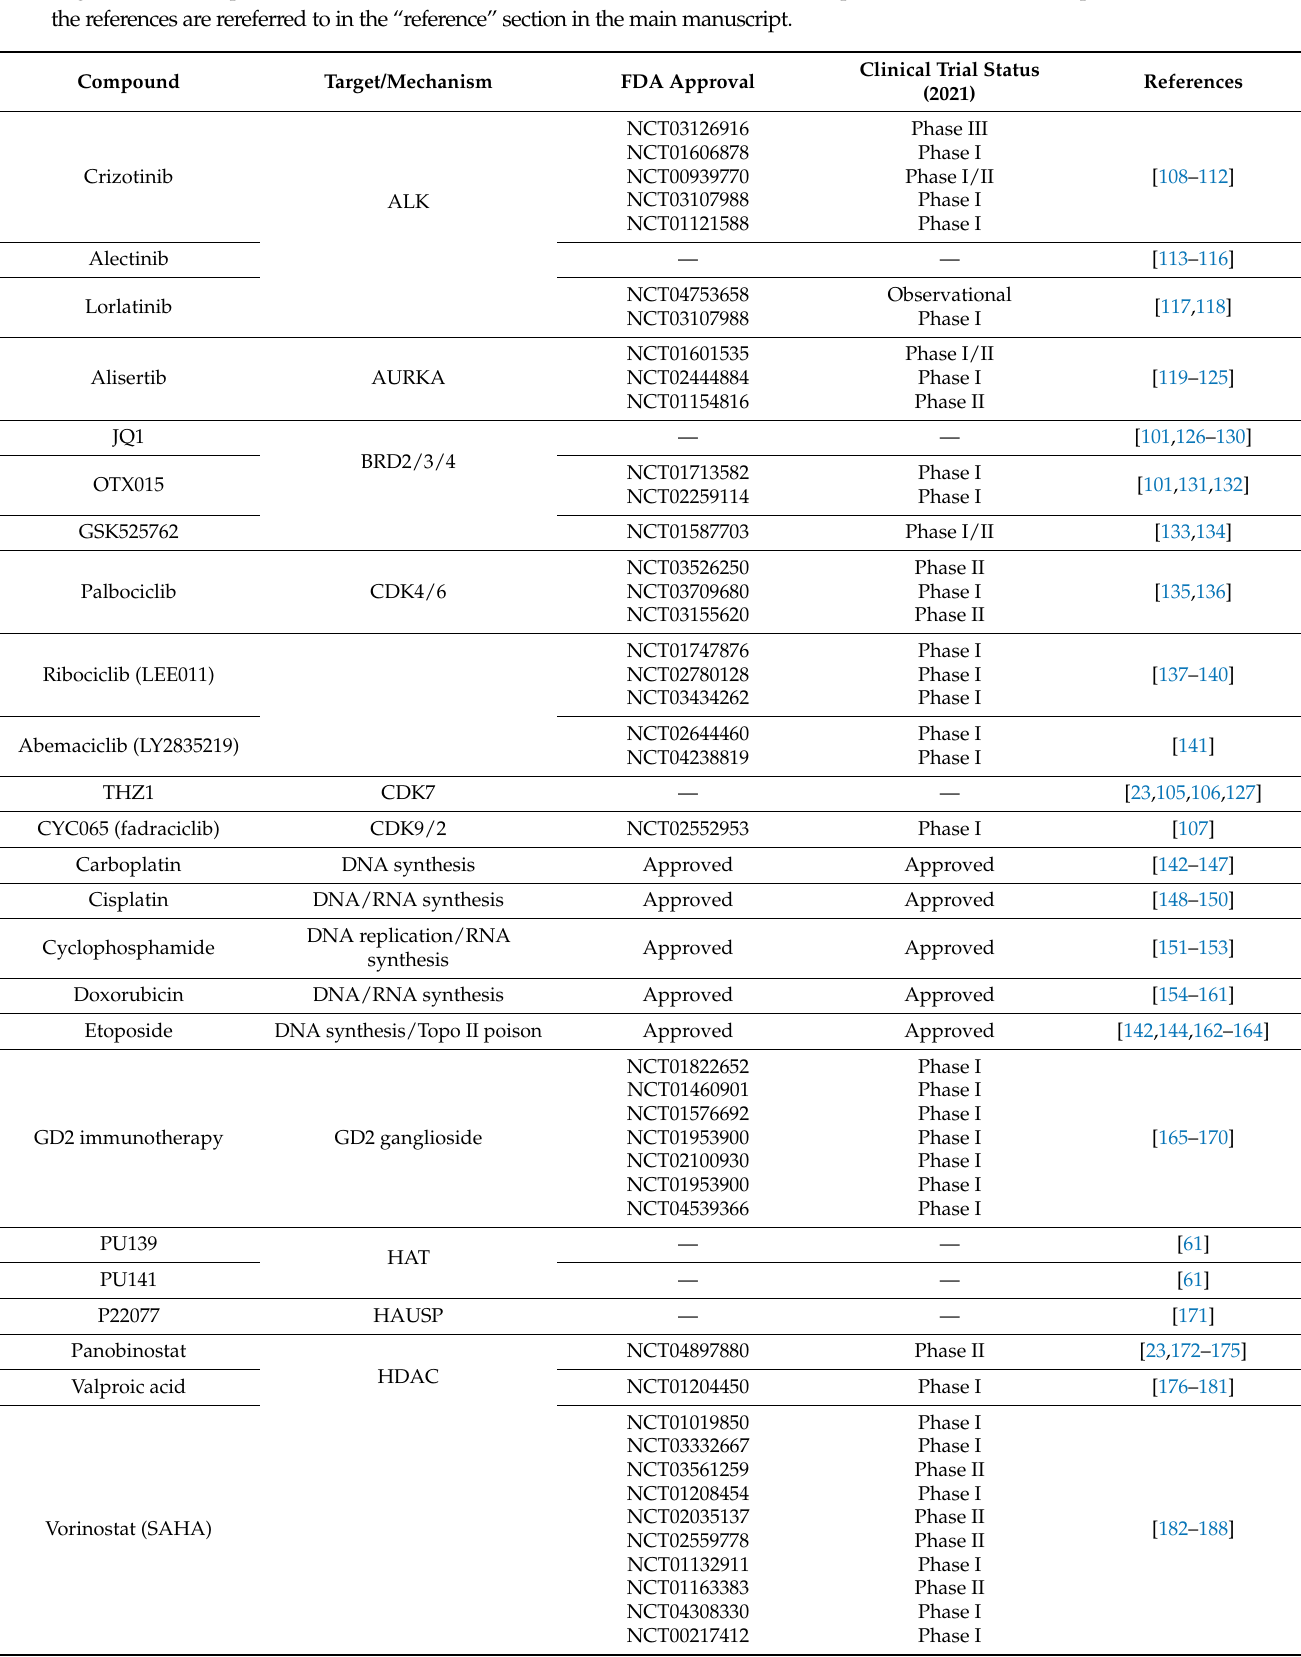
Table 2. List of chemical compounds targeting multiple regulatory networks in NB. Inhibitors are classified based on the molecular target/mechanism, preclinical (ncbi), and clinical (FDA) status relative to NB and some paediatric solid tumours updated to 2021. All the references are rereferred to in the “reference” section in the main